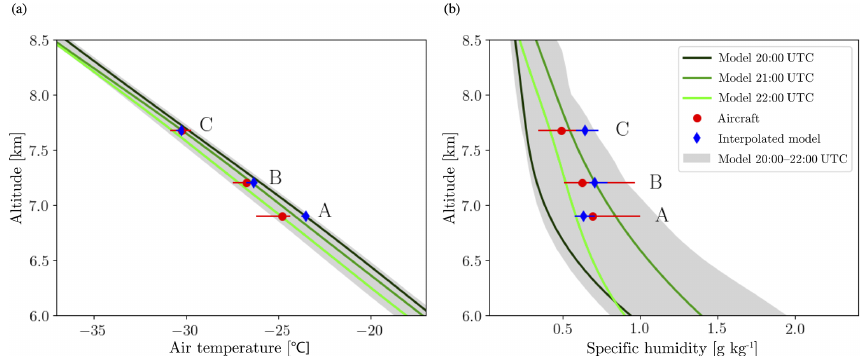
Figure 2. Comparison of (a) upstream temperature and (b) specific humidity profiles from the UM simulation and aircraft data. Upstream conditions from aircraft data are computed from the non-cloudy sections of the aircraft legs west of − 105 ◦ E. Red circles indicate the mean value along these portions of the aircraft legs, and the bars indicate the variability. The model values are taken from the grid column closest to the average location of these upstream aircraft segments (green lines) at times between 20:00 and 21:00UTC, i.e. bracketing the time of the observations between ∼ 20:40 and ∼ 21:20UTC. The cyan shading shows the variability in temperature and specific humidity in this grid column for all output times between 20:00 and 22:00UTC. The blue diamonds and bars show the model data interpolated to the flight track and evaluated in the same way as the aircraft